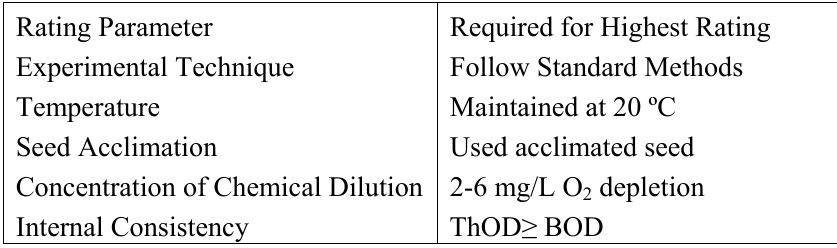
Table 1. Evaluation Criteria used for BOD Data in the DIPPR